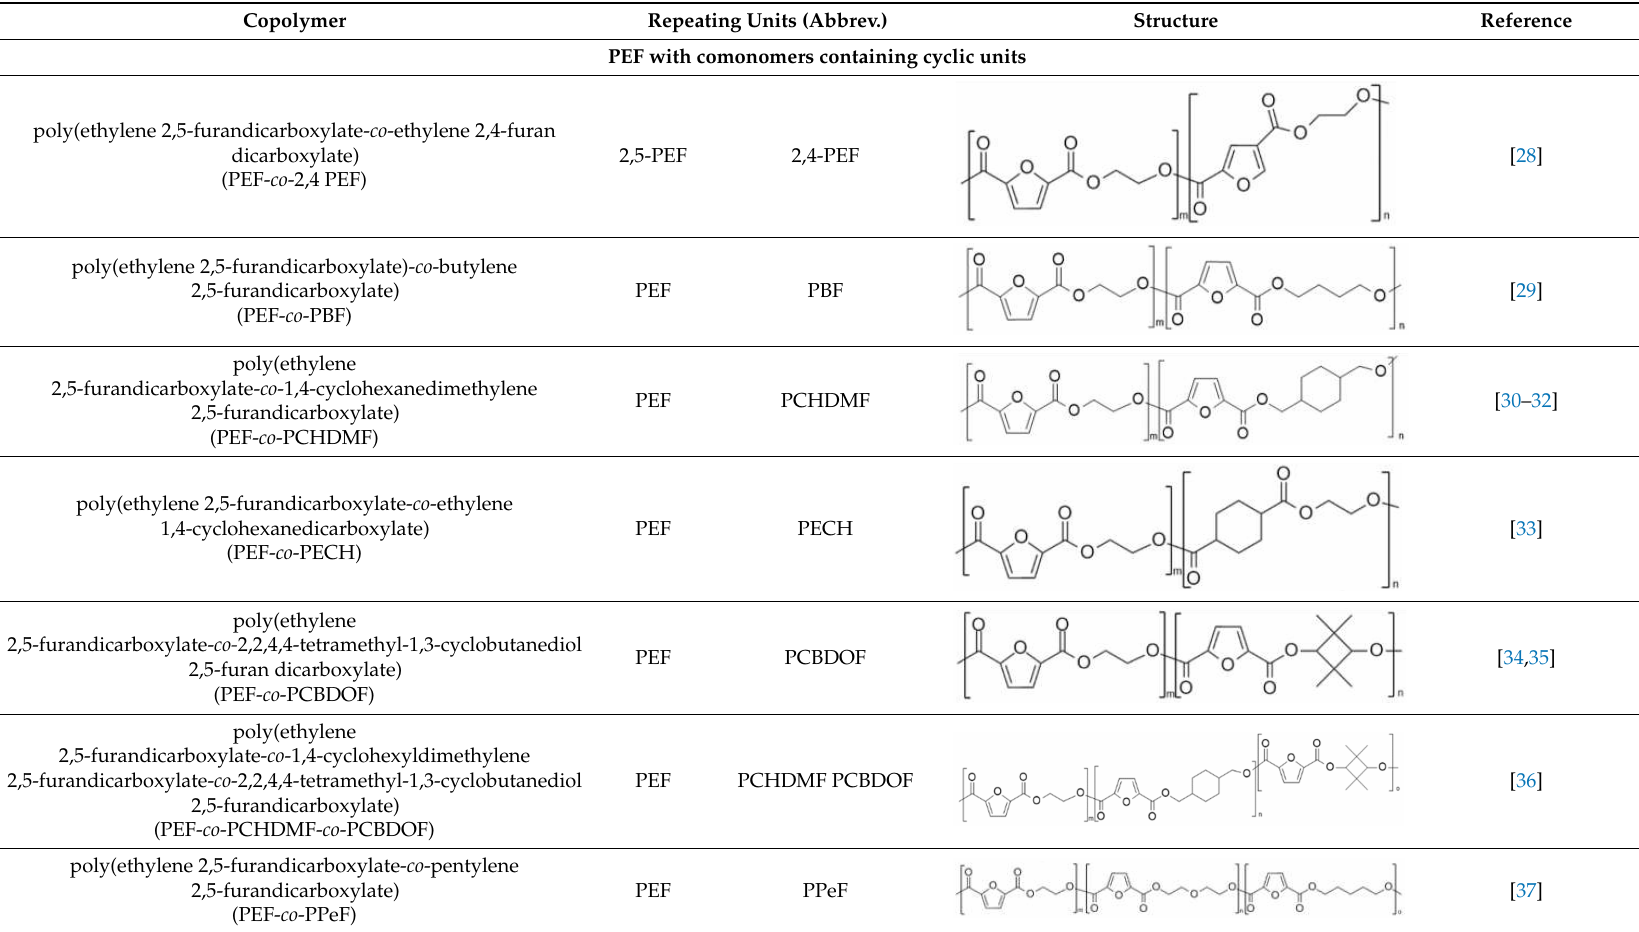
Table 1. Copolyesters with 2,5-furandicarboxylic acid (FDCA) reported in the literature. Each polymer’s abbreviation is defined in the “repeating units” columns. Copolymer Repeating Units (Abbrev.) Structure